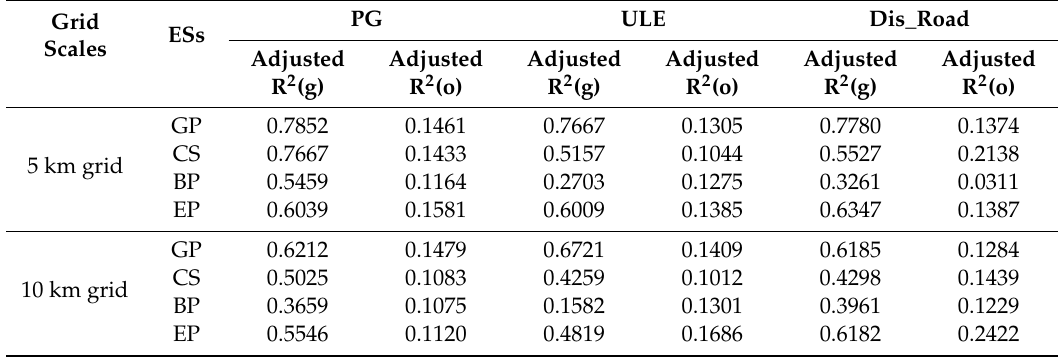
Table 3. Adjusted R 2 values of ordinary least squares (OLSs) and geographically weighted regressions (GWRs) for the relationships between ecosystem services changes and urbanization indicators.